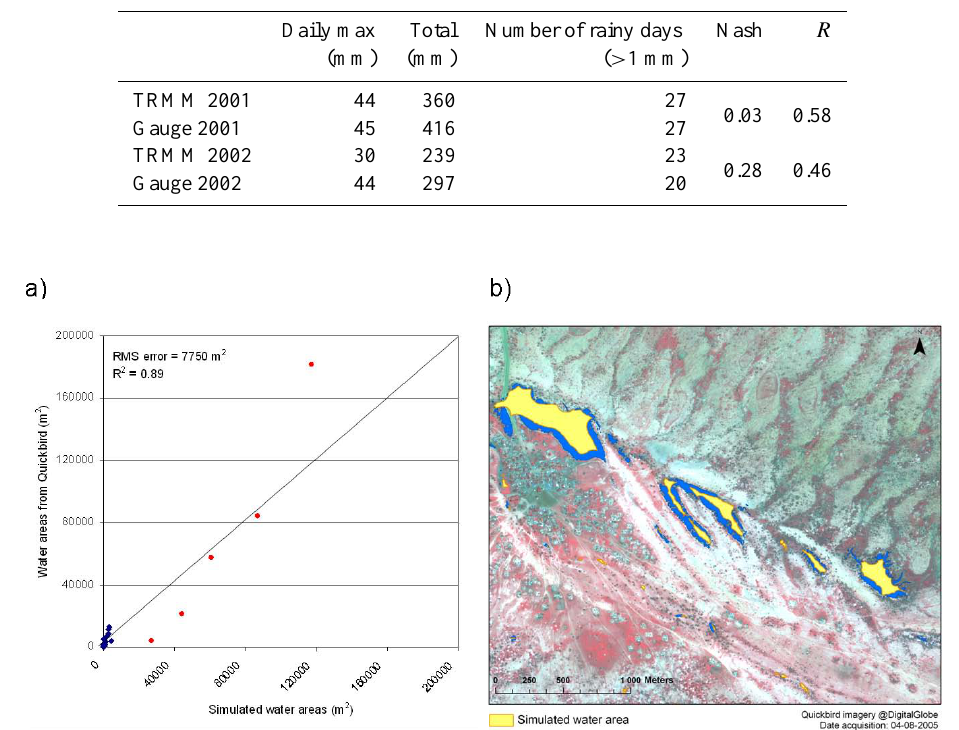
Table 6. Comparison between rain gauge and TRMM estimates for 2001 and 2002.